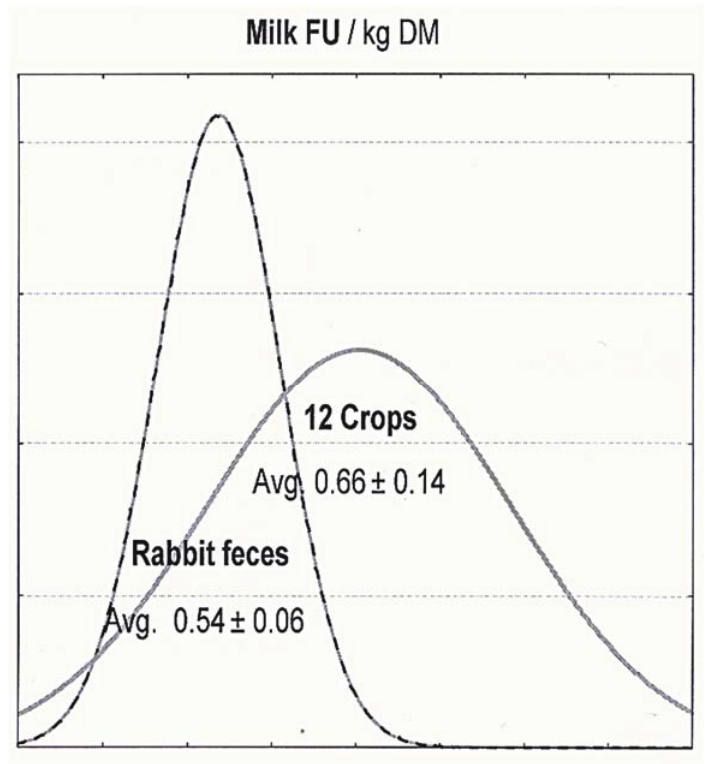
Figure 2. Distribution of the milk FU (Forage Unit) for the crops compared to the rabbit